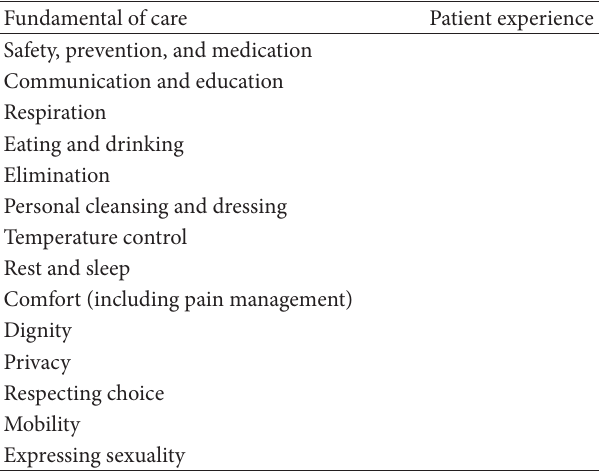
Table 1: Fundamentals of care template (source Kitson et al., 2010